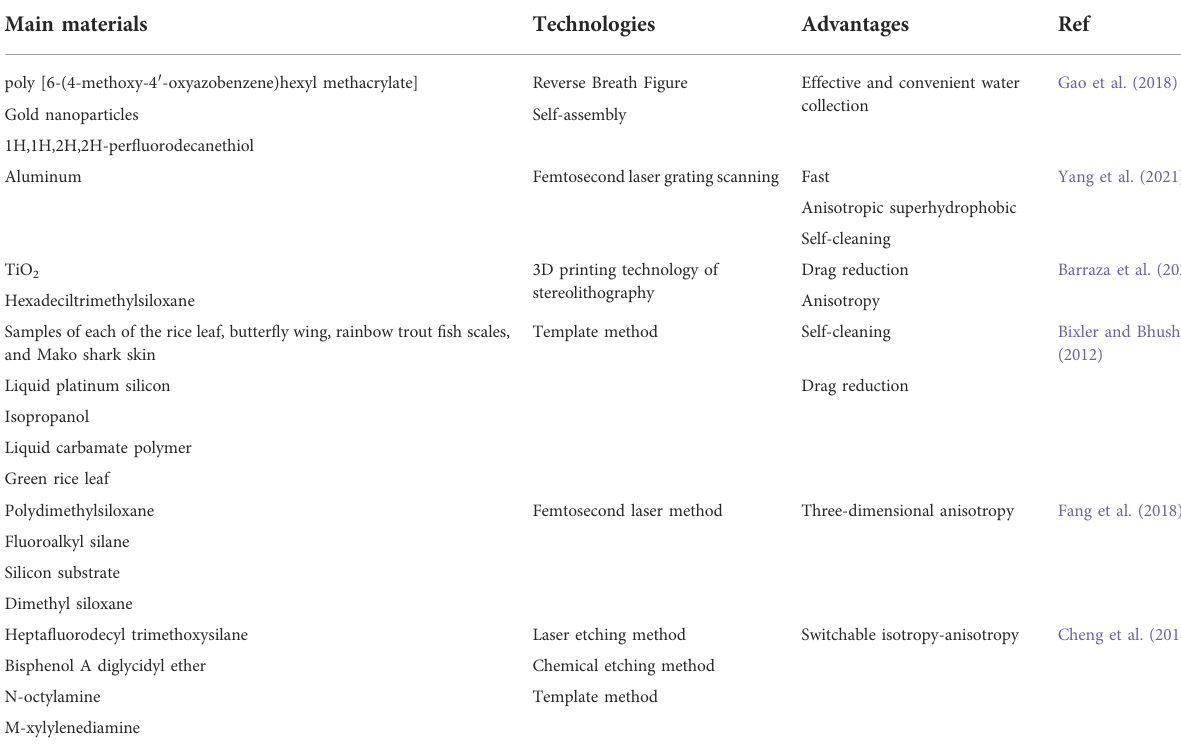
TABLE 4 Bionic product with rice leaves as